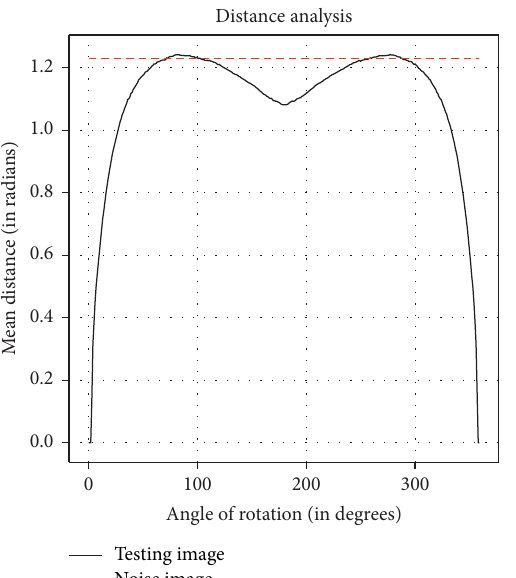
Figure 14: Rotation similarity comparison. Solid line represents the mean distance between a rotated image and its original image in the testing set. Dashed line represents the mean distance between a noise image and the testing image.